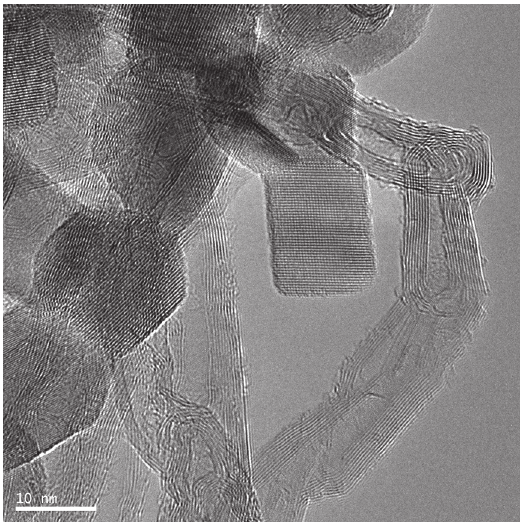
/MWCNT nanocomposite (NP 2